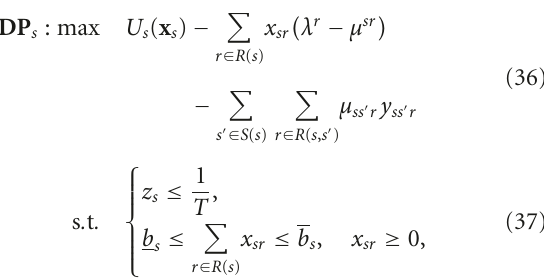
Figure 2: Topology of the simulated